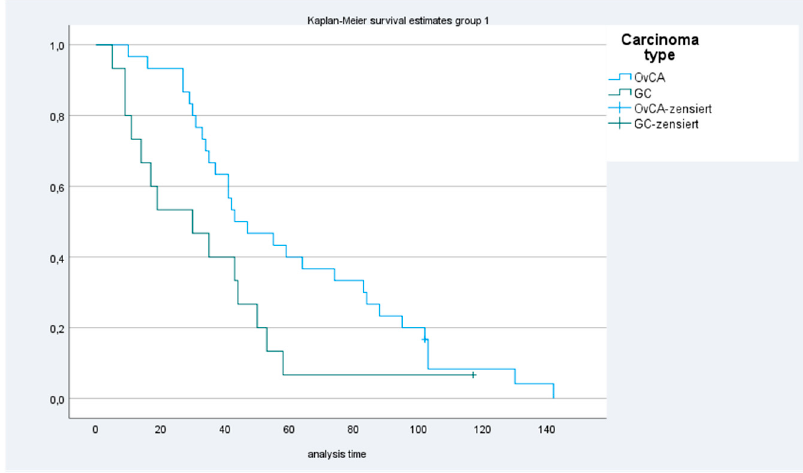
Figure 2. Kaplan–Meier curves for patients with ovarian cancer (OvCA) and with gastric cancer (GC).